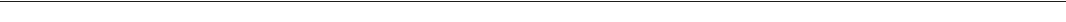
Fig. 1 The association of SNX3 with VPS35 is essential for the endosomal sorting of Wls. a HEK293T cells were transiently transfected with GFP-tagged SNX3, SNX11 and SNX12. The lysates were subjected to a GFP-trap immuno-isolation and immuno-blotted with the indicated antibodies. b Sequence alignment of human SNX11, SNX12, SNX3 and SNX3 homologues using ESPript 3.0 (76). The residues and regions mutated in the present study are highlighted. c Merged confocal images of HeLa cells transiently transfected to express wild-type or mutated versions of GFP-SNX3 (green) and immuno- stained for endogenous VPS35 (red). The scale bar indicates 11.5 μ m (see Supplementary Fig. 1 for the entire panel of images). d HEK293T cells were transiently transfected to express the indicated GFP-SNX3 construct, subjected to a GFP-nanotrap and immuno-blotted with the indicated antibodies. The fl uorescent bands, from three independent biological replicates, were quanti fi ed using a Licor Odyssey Scanner to show the relative binding of the GFP- SNX3 constructs to VPS35. Error bars indicate s.e.m. e Mapping of the targeted mutations onto the NMR derived structure of full length SNX3 (33). Green residues show those mutants that lead to a loss of VPS35 association while those residues in blue have limited effects on VPS35 binding when mutated. Note that the extended amino-terminal region prior to the β 1-strand is intrinsically disordered (33). f Schematic representation of the migration of the QL neuroblast descendants (QL.d) and the dependency of this migration on Wnt signalling. In wild type, the QL.d migrate to positions in the posterior part of the animal. In the absence of Wnt signalling, the QL.d migrate in the opposite, anterior direction. g Mutation of SNX-3 p.Y22A induces a defect in QL.d migration (the cells migrate towards the anterior instead of the posterior). *** p < 0.0001 (Student ’ s t -test from three independent biological replicates; error bars indicate s.d.). Note that complete loss of snx-3 function induces a fully penetrant defect in QL.d migration